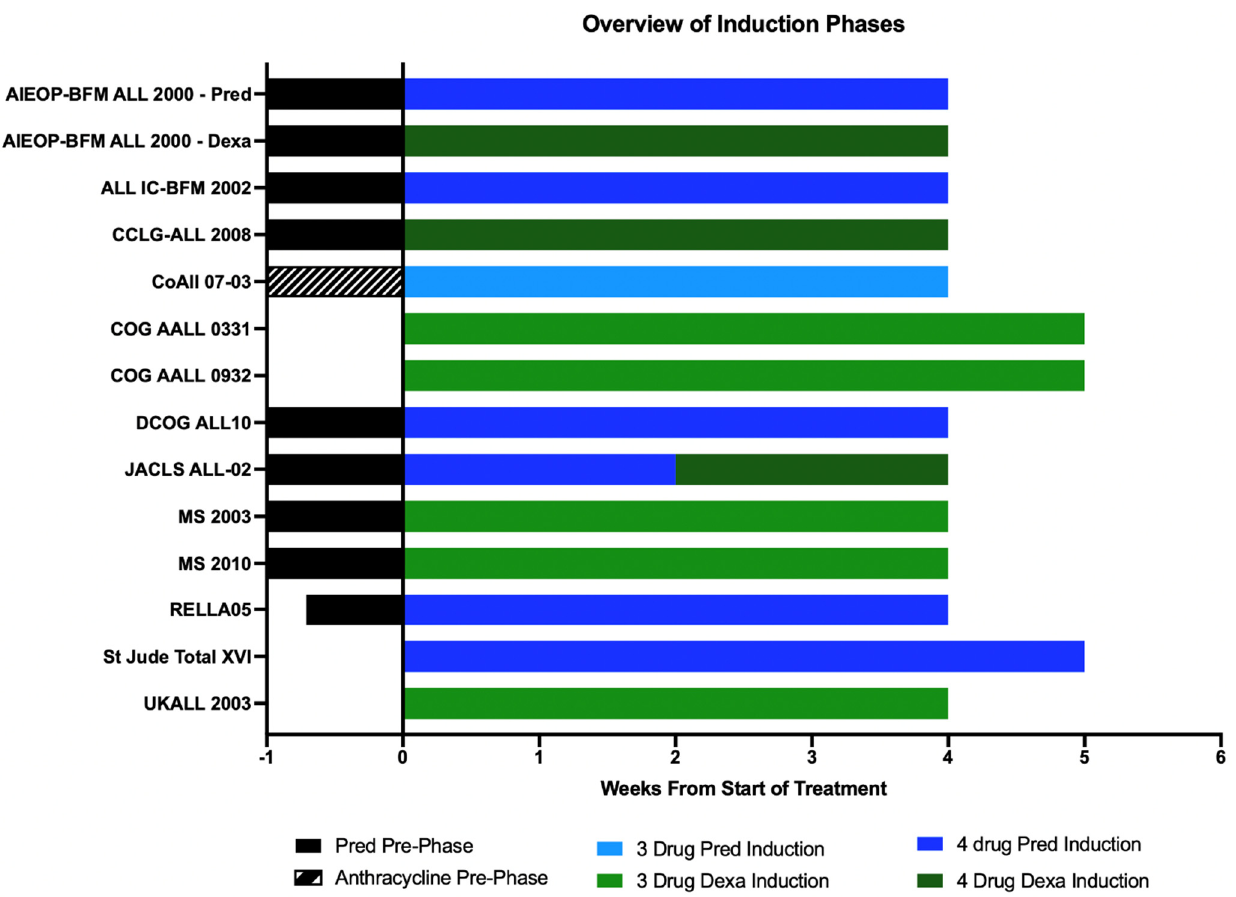
Figure 2. Induction regimens in contemporary ALL studies for low − risk patients. Prednisolone (Pred) prophase allows management of tumor lysis. 3 drug induction refers to induction protocols which include the use of Prednisolone or Dexamethasone (Dexa), Vincristine and L-asp, with the exception of patients treated on the CoALL 07-03 [21] who received 3 drug Prednisolone-based induction consisting of Prednisolone, Vinristine, and either Doxorubicin or Daunorubicin, without L-asp. This included a pre-phase comparing the responses after a single dose of either Doxorubicin or Daunorubicin. 4 drug induction protocols include the use of anthracyclines such as Doxorubicin or Daunorubicin. For LMIC, 3-drug Dexa-based induction is safer. For 4-drug induction, Pred-based induction is probably less toxic than one that is